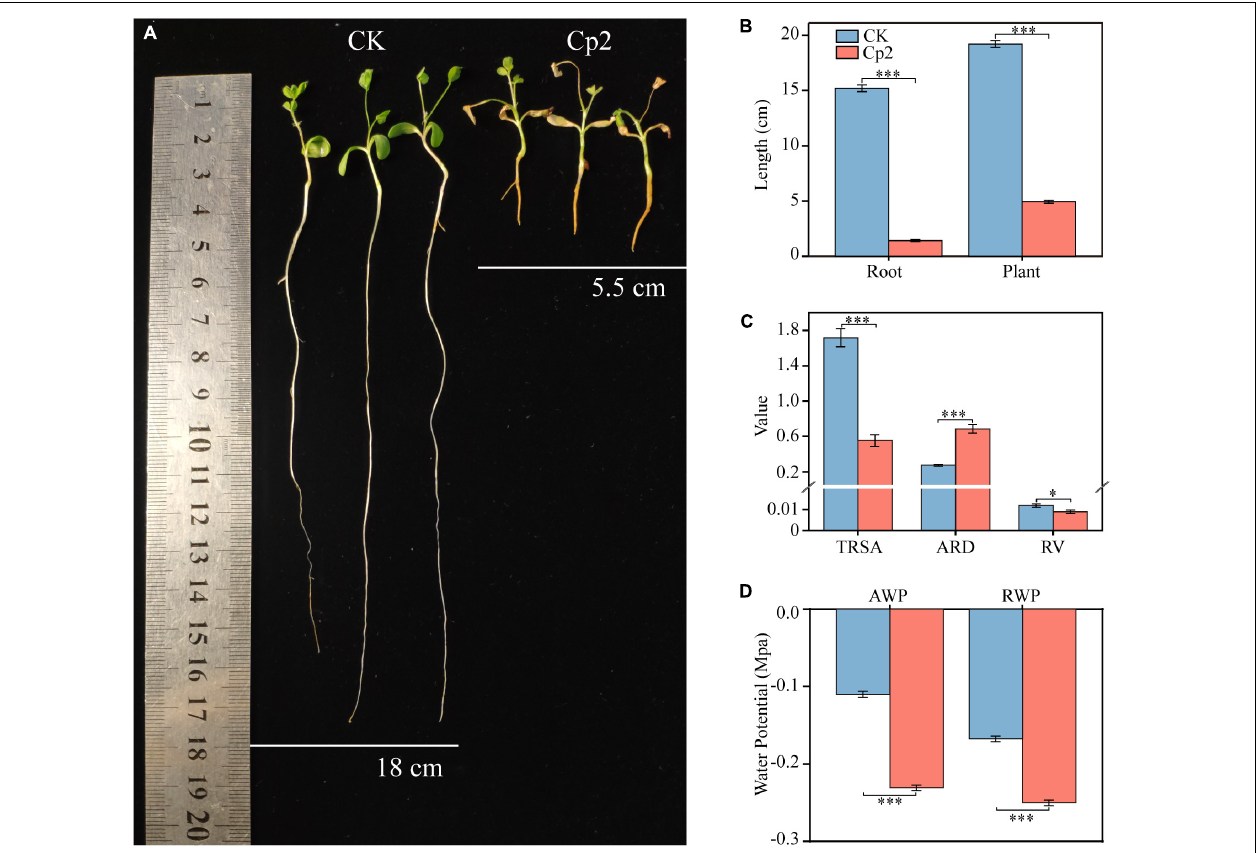
FIGURE 6 | Inhibition of alfalfa root elongation and growth by Erwinia persicina strain Cp2. (A) The picture was taken at 21 days postinoculation. (B) Changes of root and plant lengths between CK and Cp2 group (Mann–Whitney U test, n = 9). (C) Differences in the root growth parameters between CK and Cp2 group (Welch t -test, n = 6). TRSA, total root surface area (cm 2 ); ARD, average root diameter (mm); RV, root volume (cm 3 ). (D) Water potential of CK and Cp2 group on day 21 (Independent samples t -test, n = 12). AWP, ambient water potential; RWP, root water potential. ∗ P < 0.05, ∗∗∗ P < 0.001; mean ±